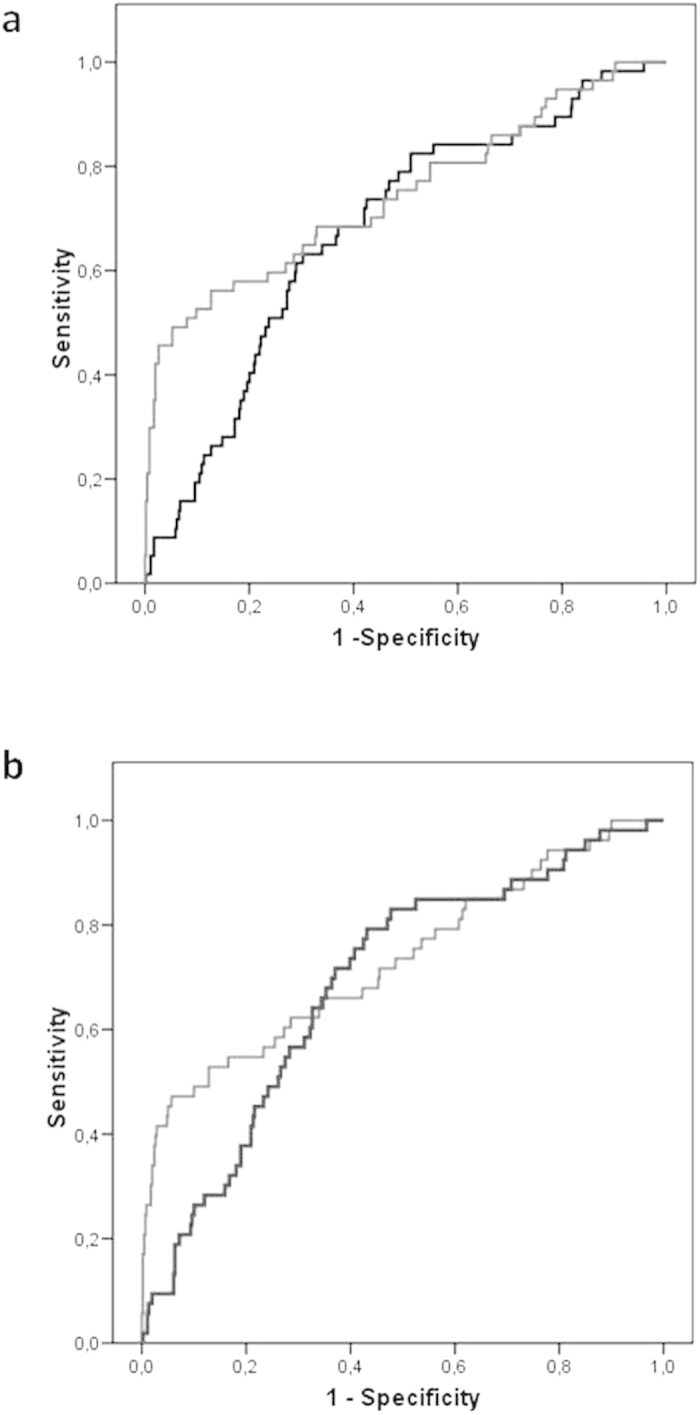
ROC curves for the diagnosis of advanced neoplasia (A) and advanced adenomas (B).The black curves corresponds to serum MMP-9 (log10MMP-9) corrected by confounders gender and age; the grey curves corresponds to FIT [log10(FIT + 2)] corrected by confounders gender and age.